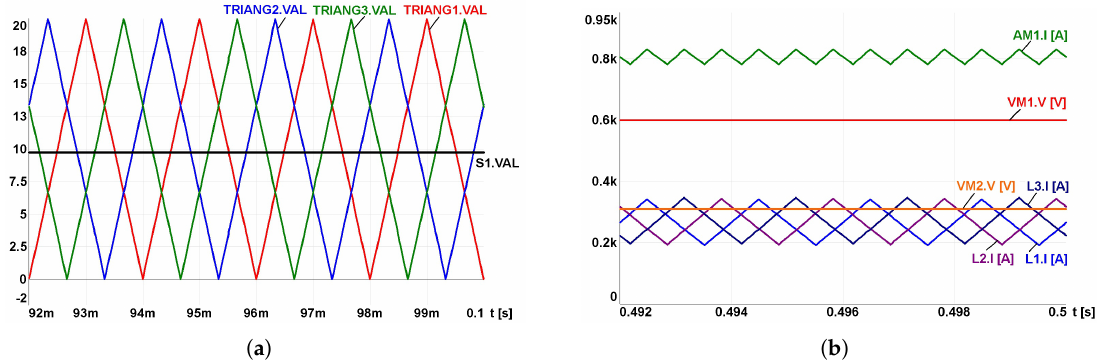
Figure 5. Waveforms in the boost mode (model from Figure 4a): ( a ) control, ( b ) currents and